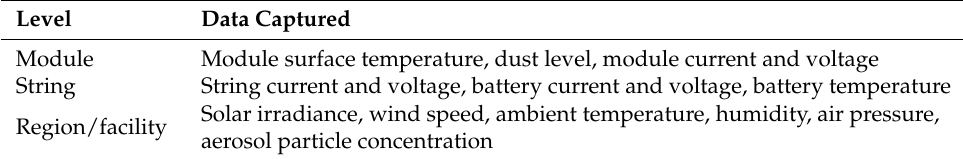
Table 2. Examples of data captured at module, string, and region